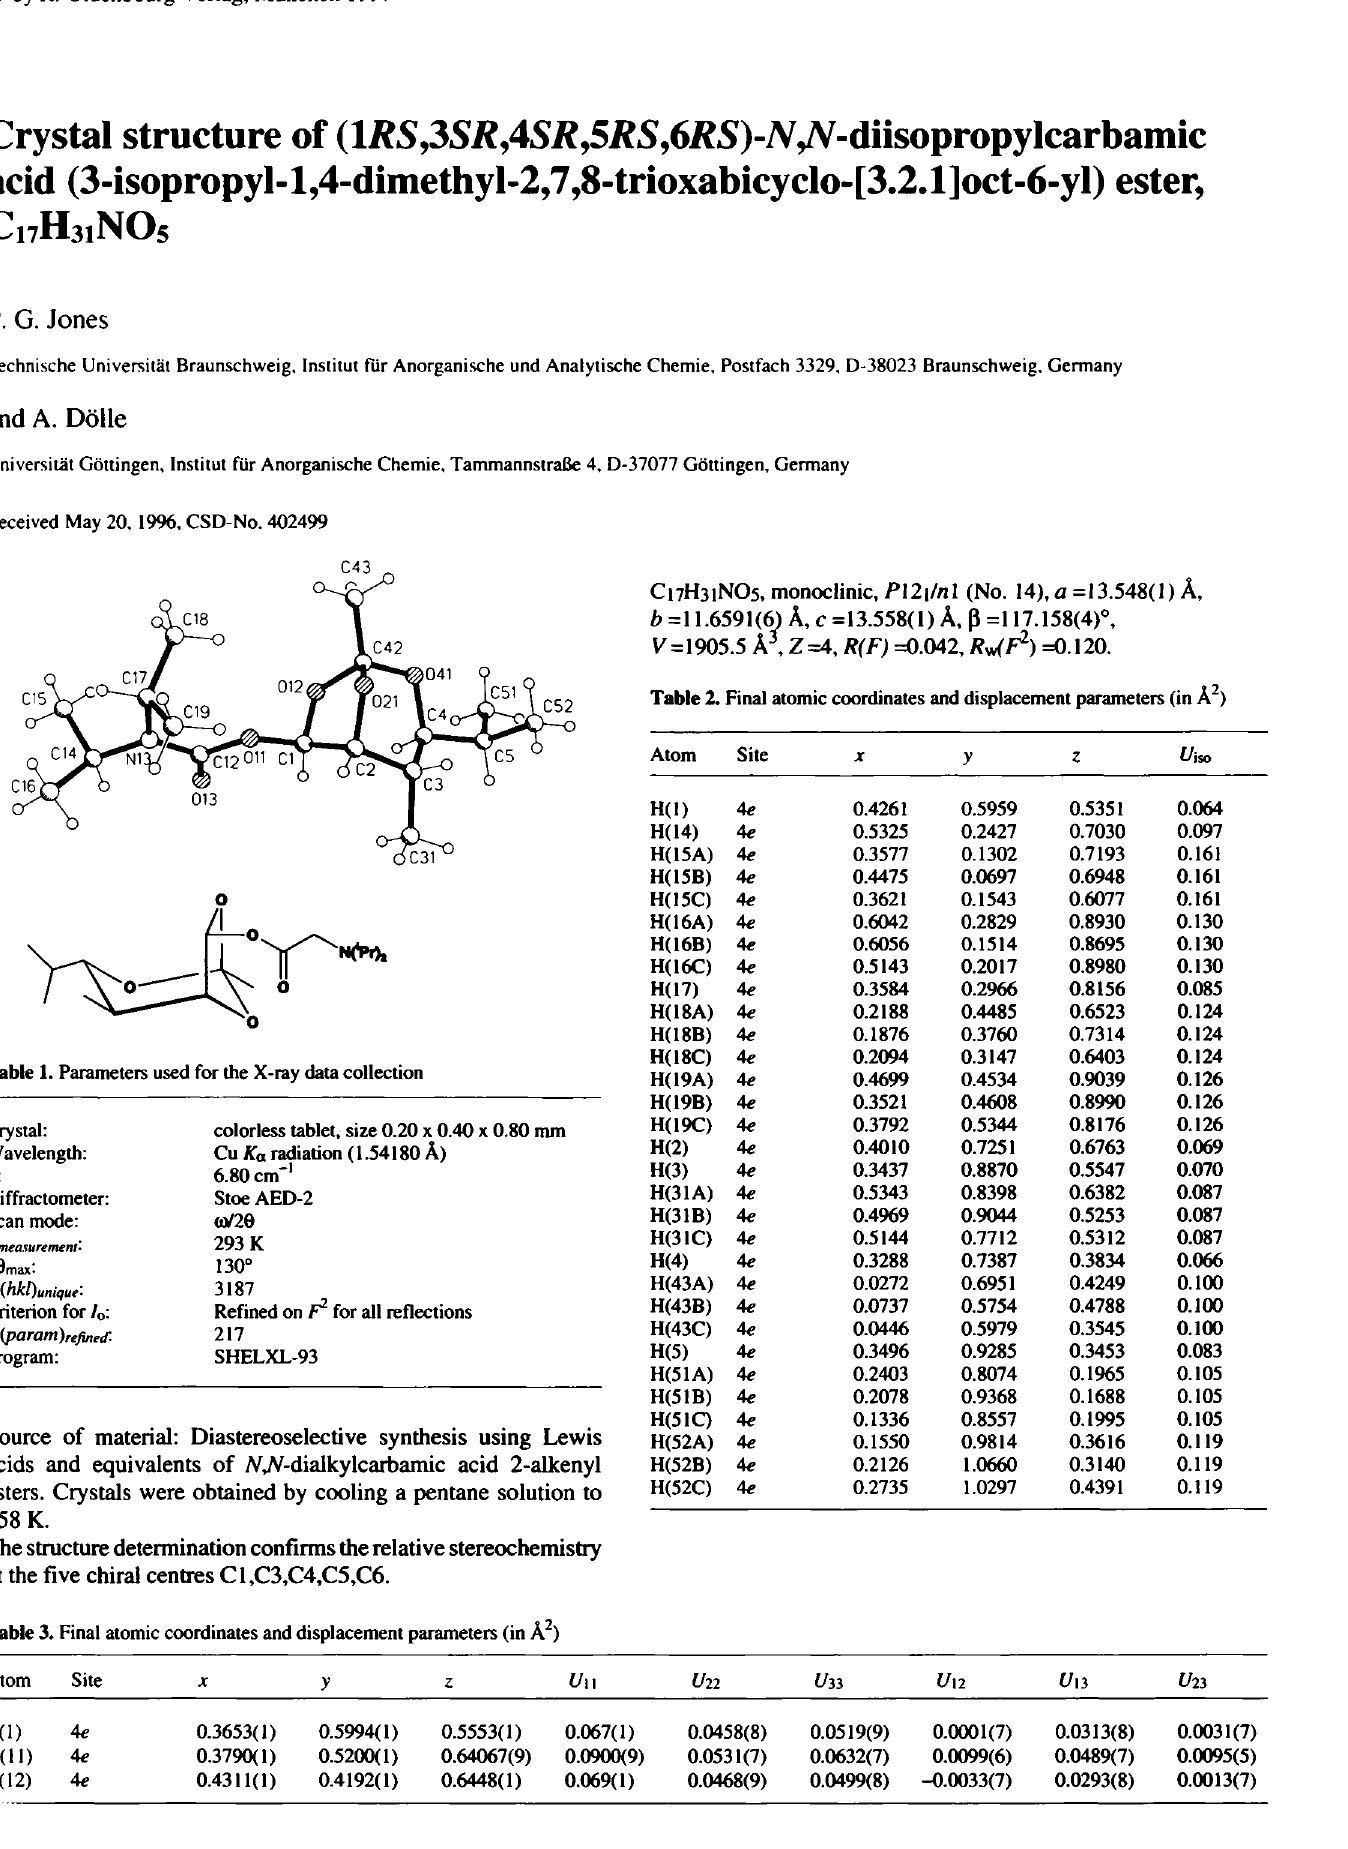
Table 2. Final atomic coordinates and displacement parameters (in Â 2 )